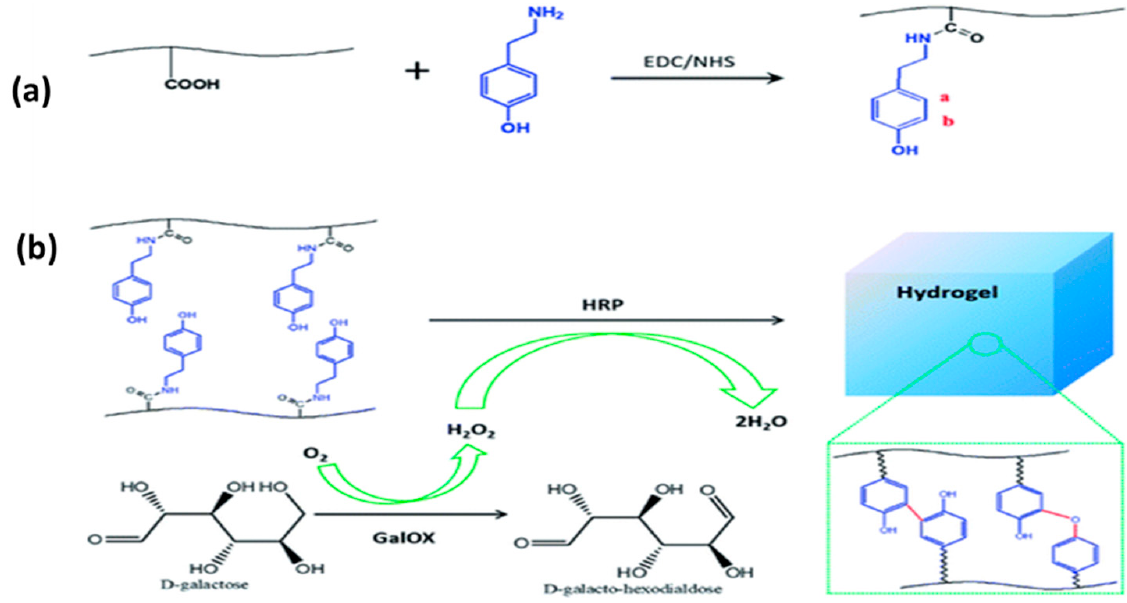
Figure 15. Synthetic scheme of; ( a ) the hyaluronic acid–tyramine (HT) conjugate and ( b ) hydrogel formation by dual-enzymatically crosslinked HRP and GalOX (adapted with permission from Wang et al., 2020).